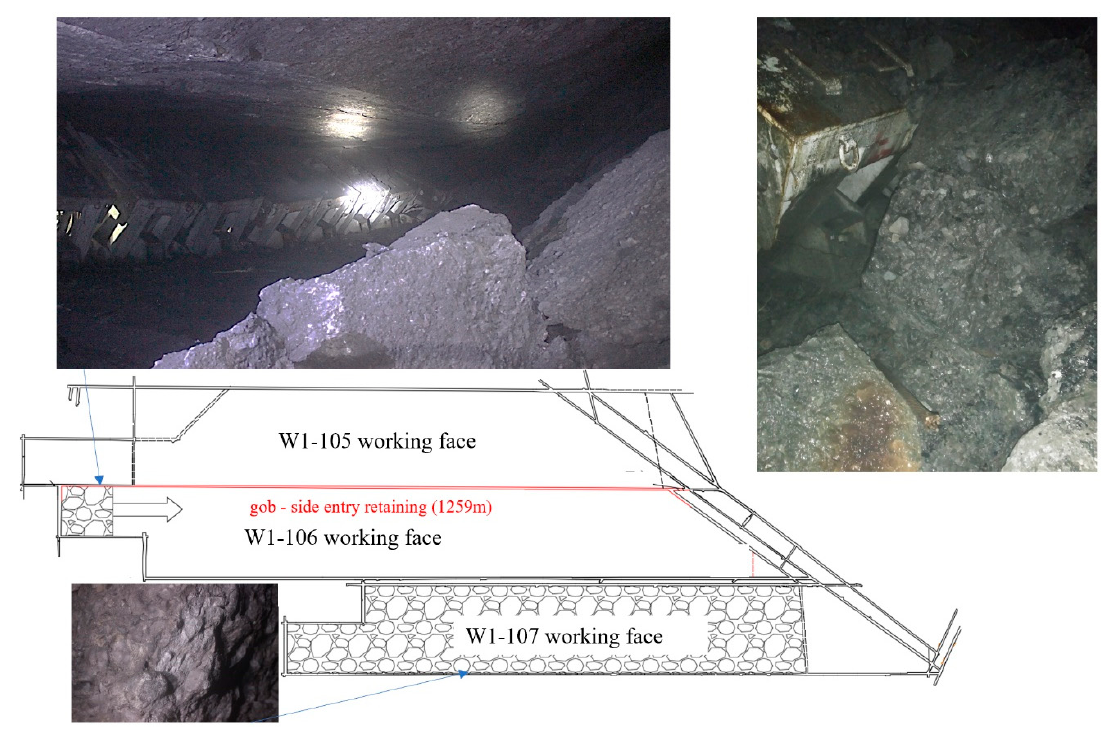
Figure 6. The layout of the test working face and lithology of the collapsed roof.